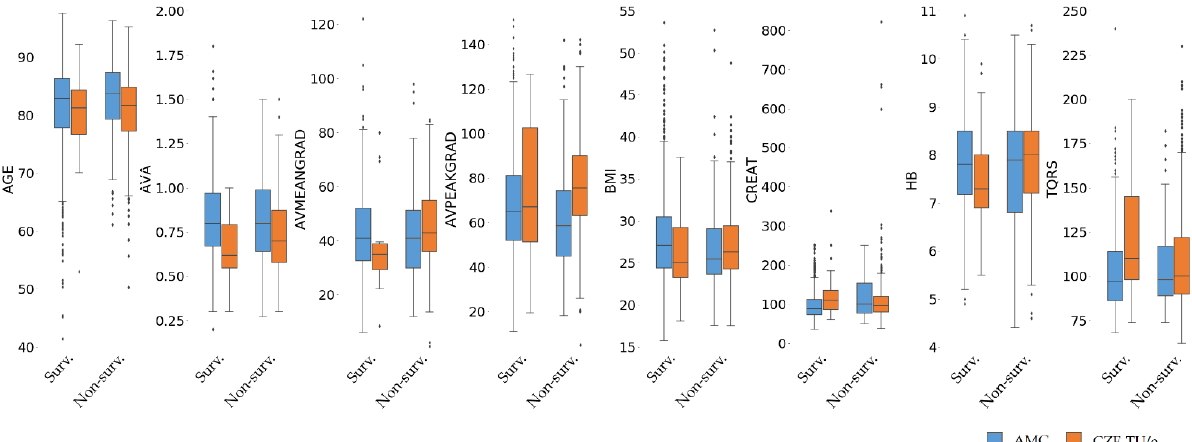
Figure 4. Boxplot distributions of the numerical features for the two different centers. AMC and CZE-TU/e feature distributions are shown in blue and orange, respectively. Imputed data for missing values are not included to avoid influence on the original data distribution.